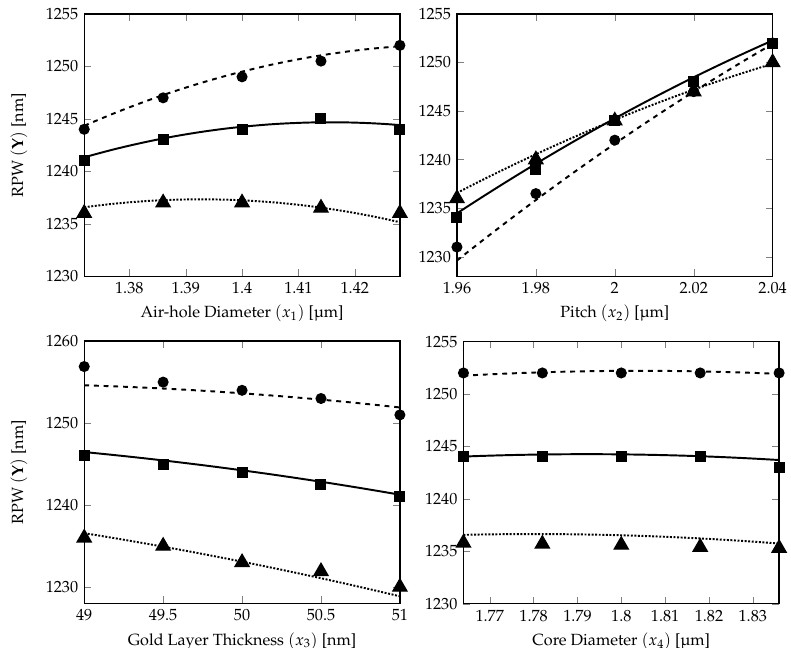
Figure 6. Effects of four factors (air-hole diameter, pitch, gold layer thickness and core diameter of analyte) on RPW curves generated from quadratic CCD ± 2% model. The dotted, solid and dashed curves show the RPW calculated from the ± 2% DoE model (11) with three parameters (expected target parameter on x -axis) fixed at their own tolerance levels, − 2%, 0% and + 2%, respectively. −→ + 2%) are calculated from corresponding The RPW marks ( (cid:78) −→ − 2%, (cid:4) −→ 0% and (cid:32) FEM